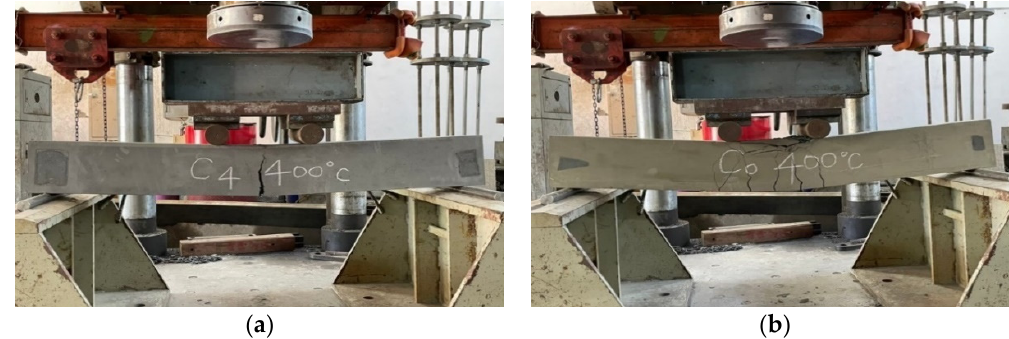
Figure 11. The tensile failure in the flexural test of beams after being subjected to 400 °C: ( a ) the experimental group and ( b ) the control group.